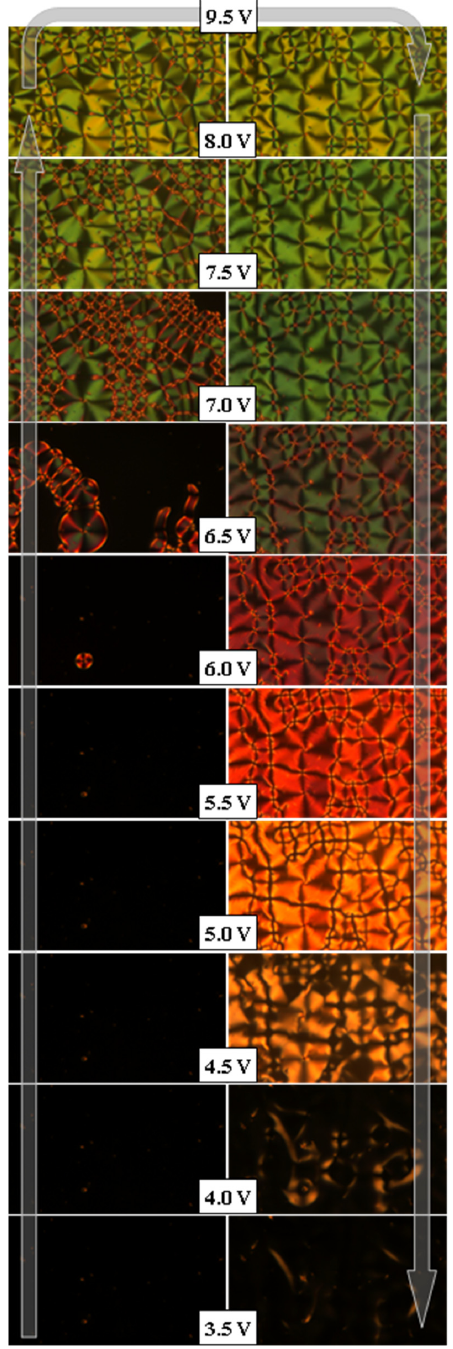
Figure 9. Polarising microscope image of the bend Fréedericksz transition in the N TB phase just below N–N TB transition in homeotropically aligned cell. Each image frame is 0.5 mm. The material MGTP7 with Δε < 0 is used. T = 86.7 °C, 5.7 µm homeotropic cell. Recording of textures was automatically initiated with a voltage step of 0.5 V 0-Pk . A delay time of 30 minutes was inserted in the program for recording the results between the two successive data points. Voltage range in the experiment varies from: 0 to 9.5 V 0-Pk square wave. Only textures for selected voltages are displayed to avoid having too many images, the in-between omitted textures are not significantly different from those displayed. In the left column of the figure, the applied voltage is increasing and in the right column the voltage is decreasing. We observe (i) sharp boundaries between the switched (bright) and the un-switched (dark) states (areas here) as well as the (ii) differences in between the threshold voltages between the two